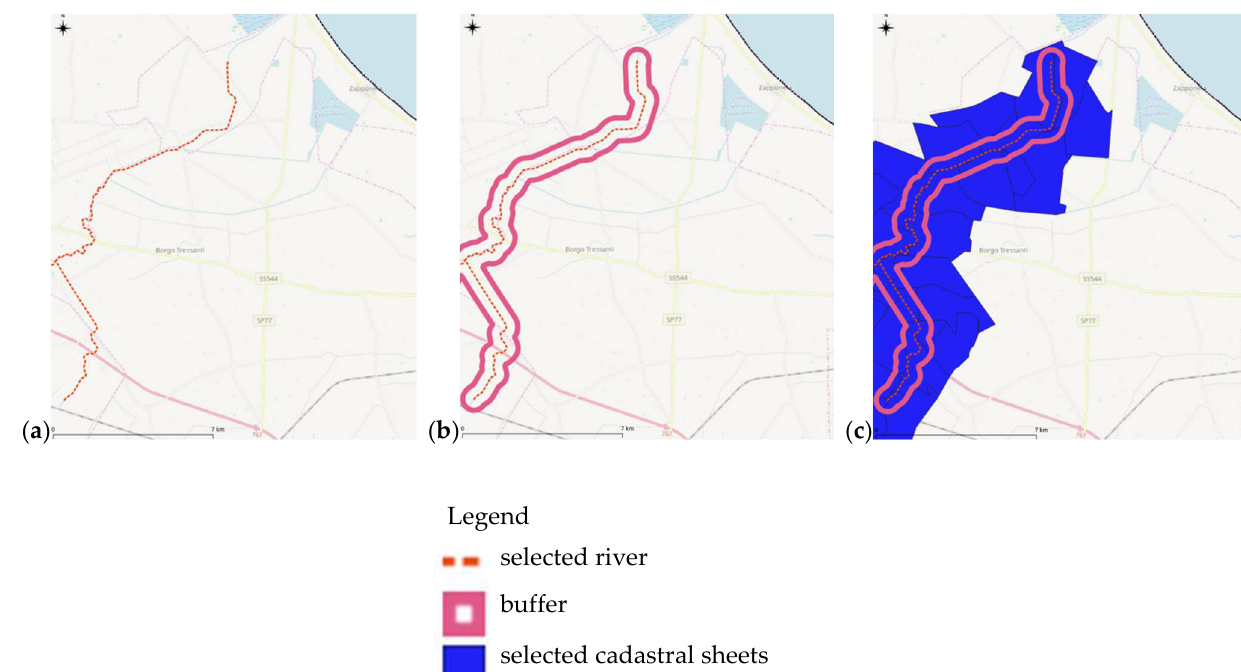
Figure 10. Example of the final perimeter of surface water bodies with identification of cadastral sheets for a simplified administration of the NVZs. ( a ) Identification of the river; ( b ) creating the buffer; and ( c ) topological overlay with cadastral sheets.